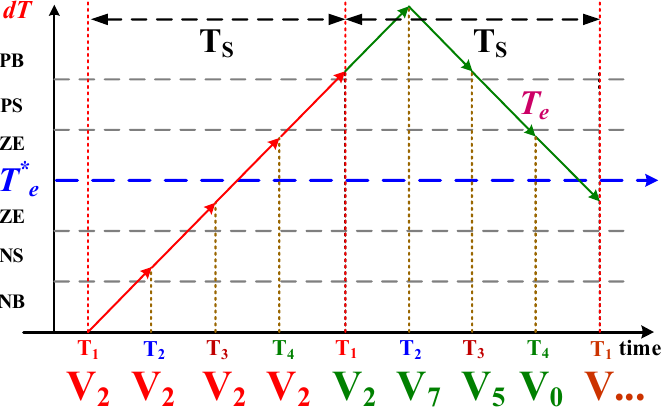
Figure 10. Variation in dT with sampling time ( T s ), which is equal to four times clock time T C .